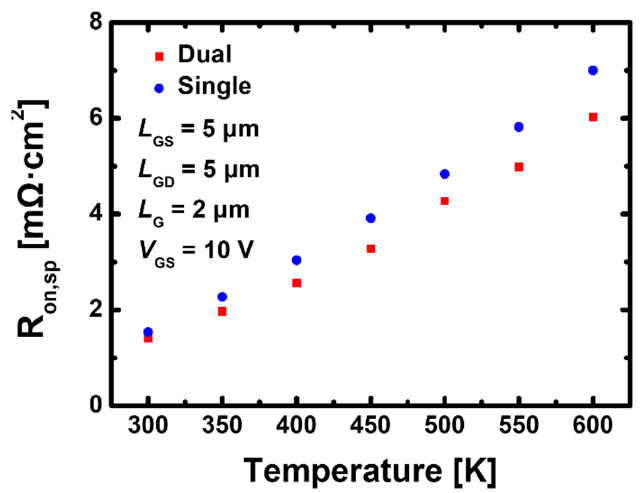
Figure 7. Specific on resistance according to internal temperature obtained from I D - V D curve in GaN device using the stacked TiO 2 /Si 3 N 4 dual-layer insulator and Si 3 N 4 single-layer insulator.